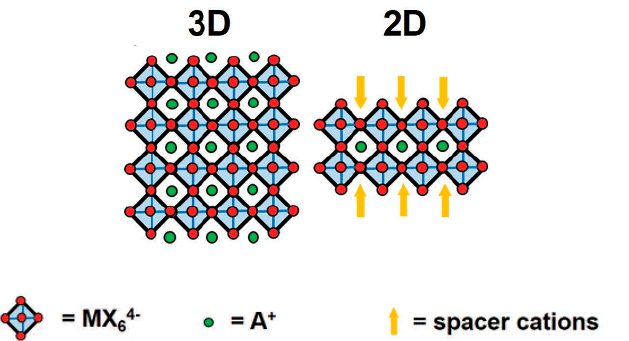
Figure 1. Structure of 3D ( left ) and 2D ( right ) perovskites, reproduced with permission from [28].